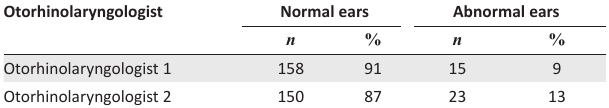
TABLE 1 : Summary of video otoscopic